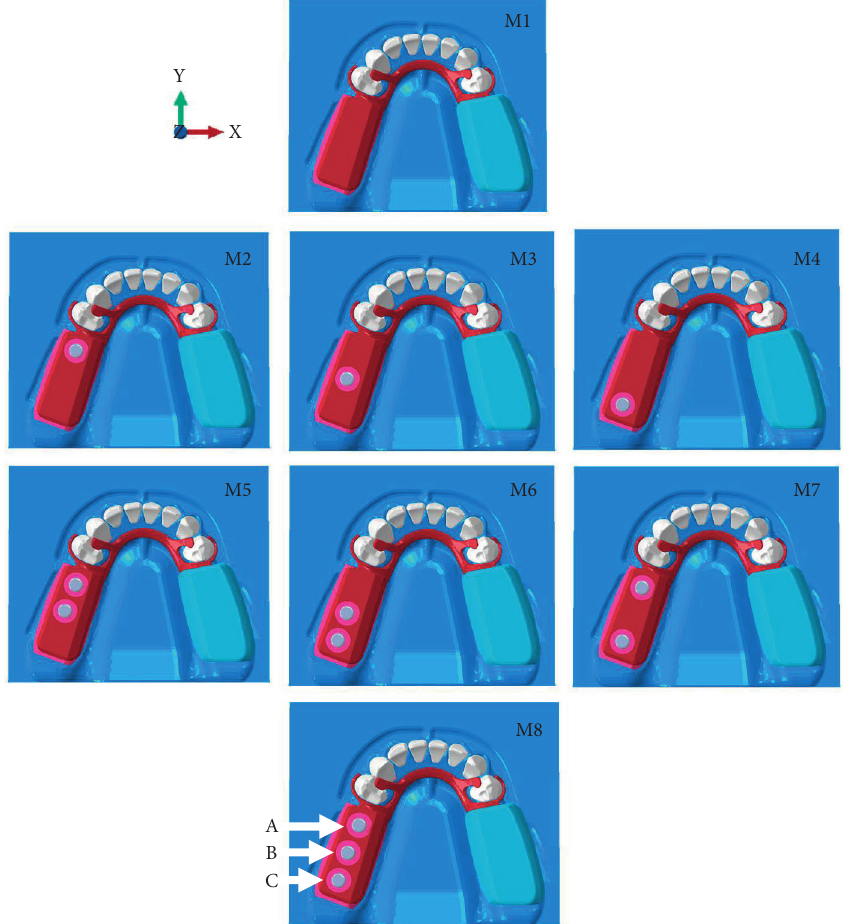
Figure 1: Eight models classified by locations and numbers of mini dental implant. Implant at second premolar (A), first molar (B), and second molar (C) were distally placed 6.5, 11.5, and 16.5mm from abutment tooth, respectively. Table 1: Properties of finite element model components. Table 2: Material properties of finite element models Model